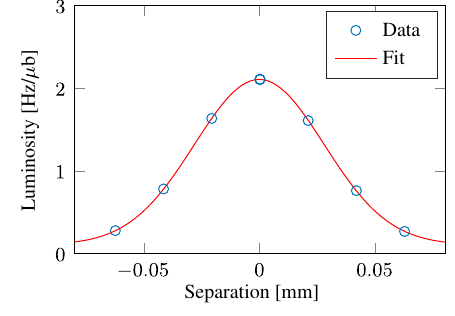
FIG. 3. Fitted beam profile from a scan in one